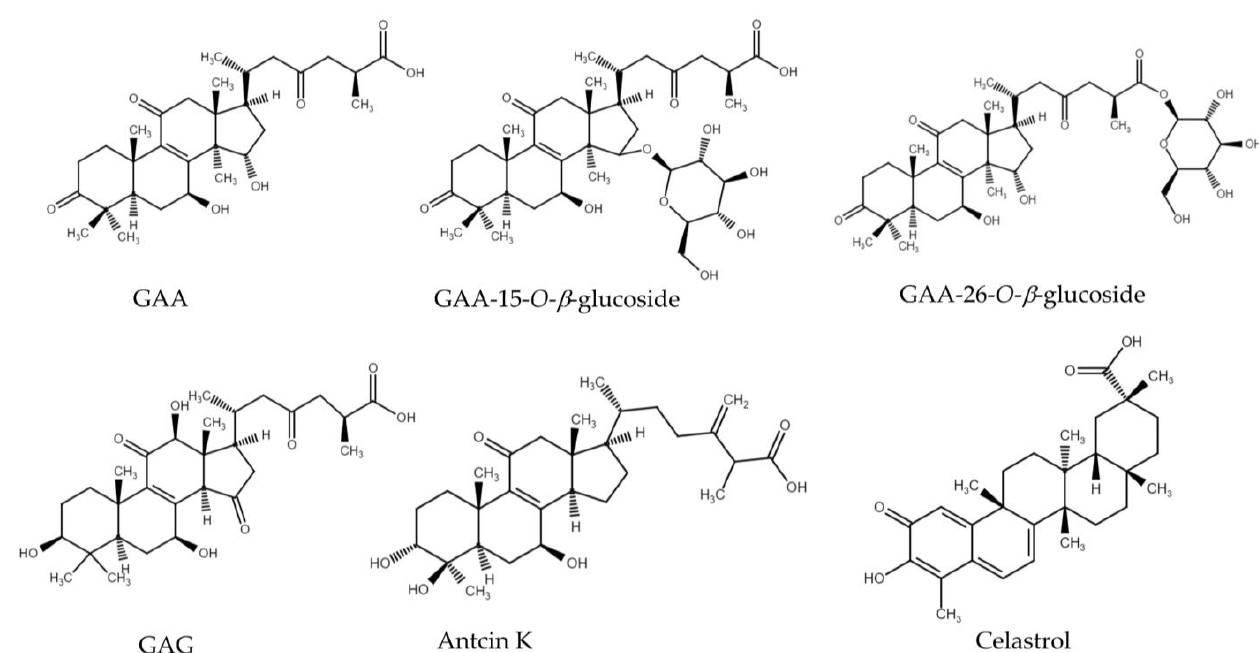
Figure 4. The chemical structures of ganoderic acid A (GAA), ganoderic acid G (GAG), GAA-15- O - β -glucoside, GAA-26- O - β -glucoside, antcin K, and celastrol. Table 1. Glycosylation activity 1 of Dg AS toward tested triterpenoids at different pH and sucrose